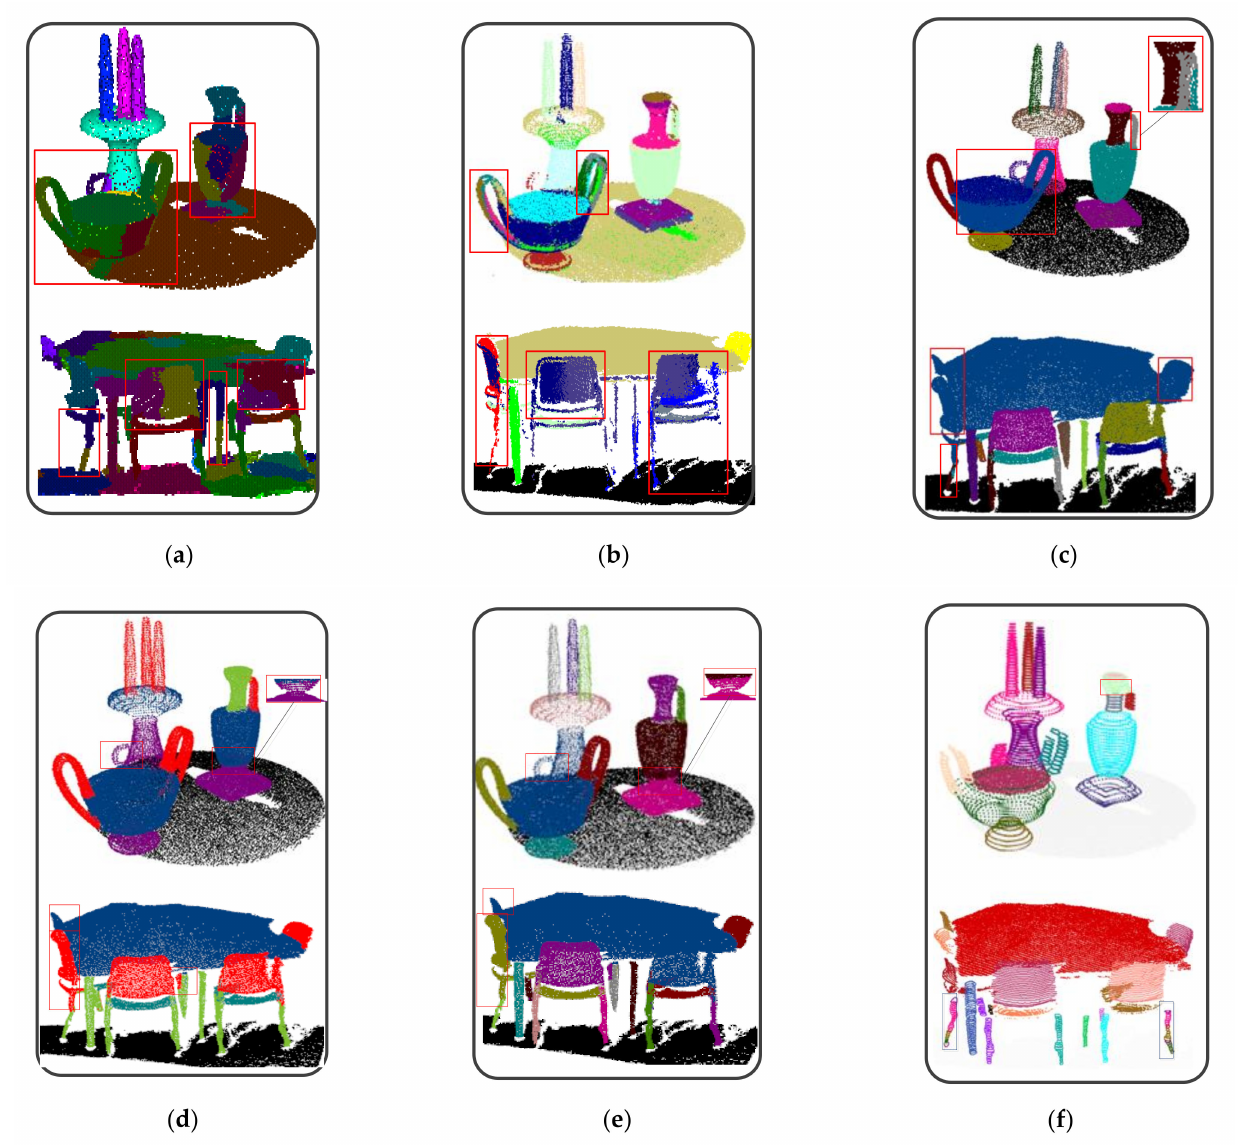
Figure 15. Components of the indoor scene models: ( a ) LCB; ( b )RANSAC; ( c ) CRF; ( d ) Semantic segmentation result of PointNet++; ( e ) Instance segmentation result of PointNet++; ( f ) The pro- posed